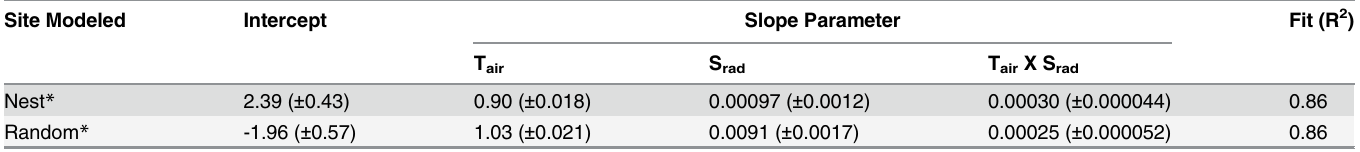
Table 1. Model outputs for black bulb temperature (T bb ) as a function of ambient temperature (T air ) and solar radiation (S rad ) at northern bobwhite nest sites and landscape sites at the Packsaddle WMA, Oklahoma, USA (2013 – 2014) (n = 7,008). Site